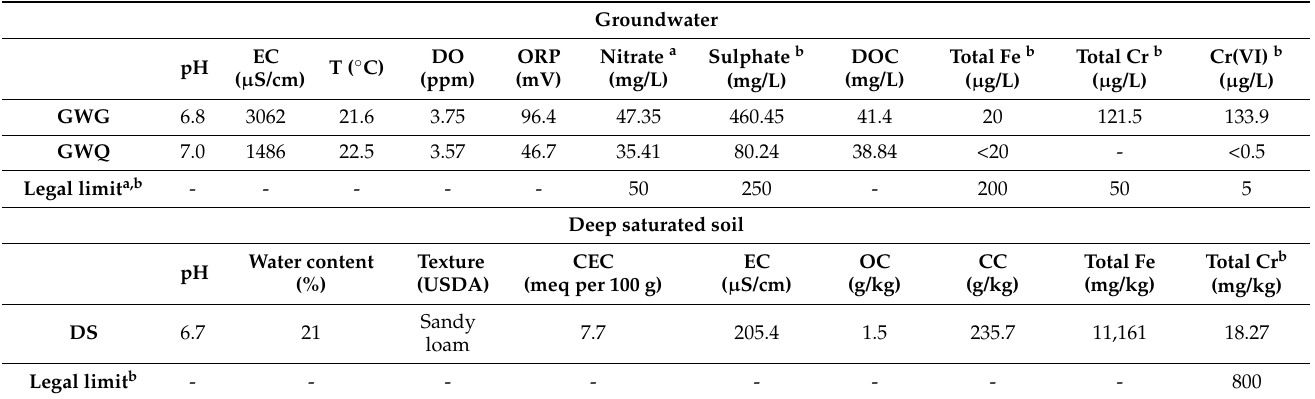
Table 2. Characterization of the groundwater and deep saturated soil